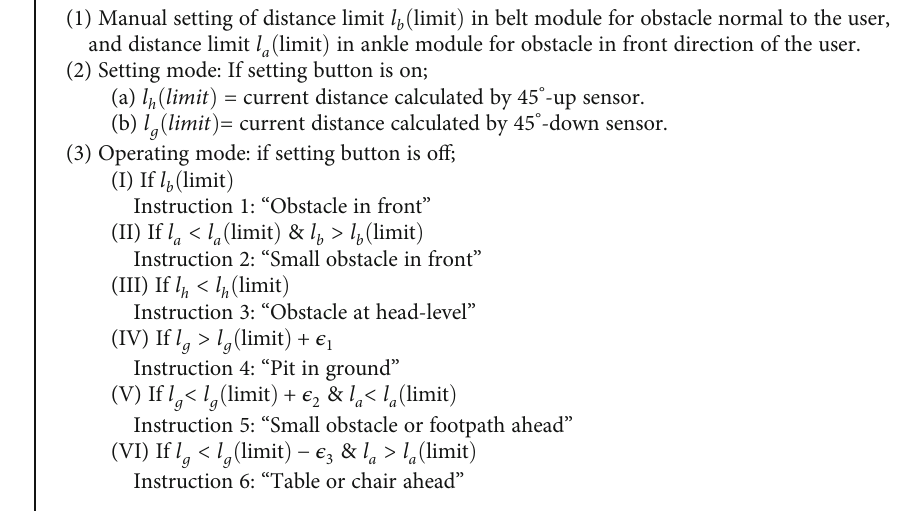
Algorithm 1. Algorithm for working of the proposed assistive device.